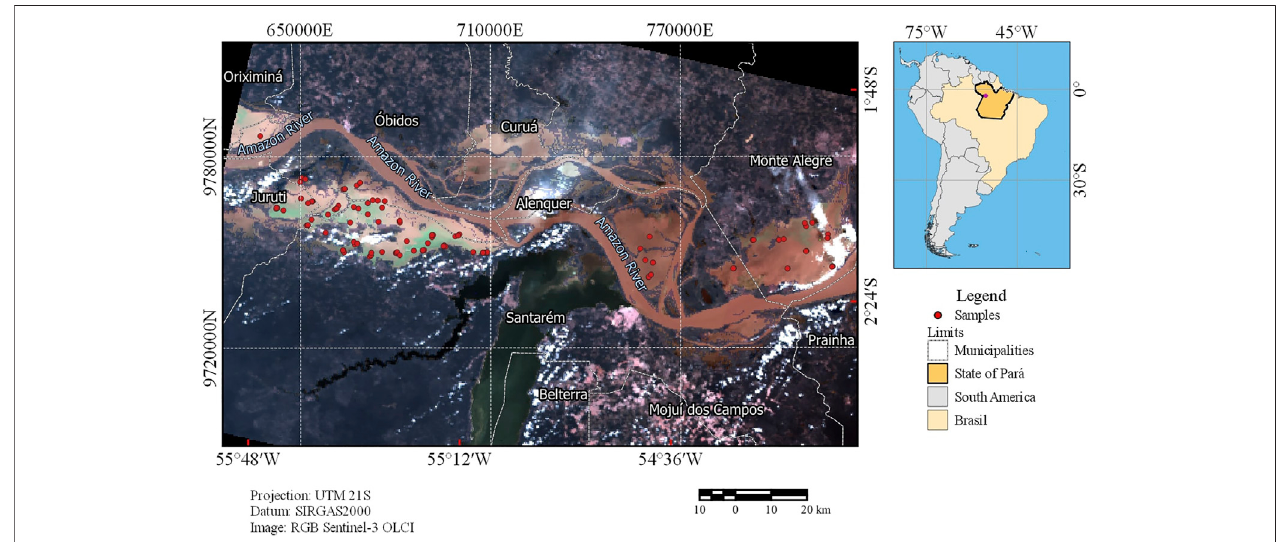
FIGURE2| StudyareawithAmazon fl oodplainlakes:LagoGrandeCuruai(LGC),MonteAlegre,Paru,Pacoval,andAramanaí.Samplinglocationsarerepresented as red dots. Background image: true-color composite of Sentinel-3 OLCI image acquired on 16 July 2016.